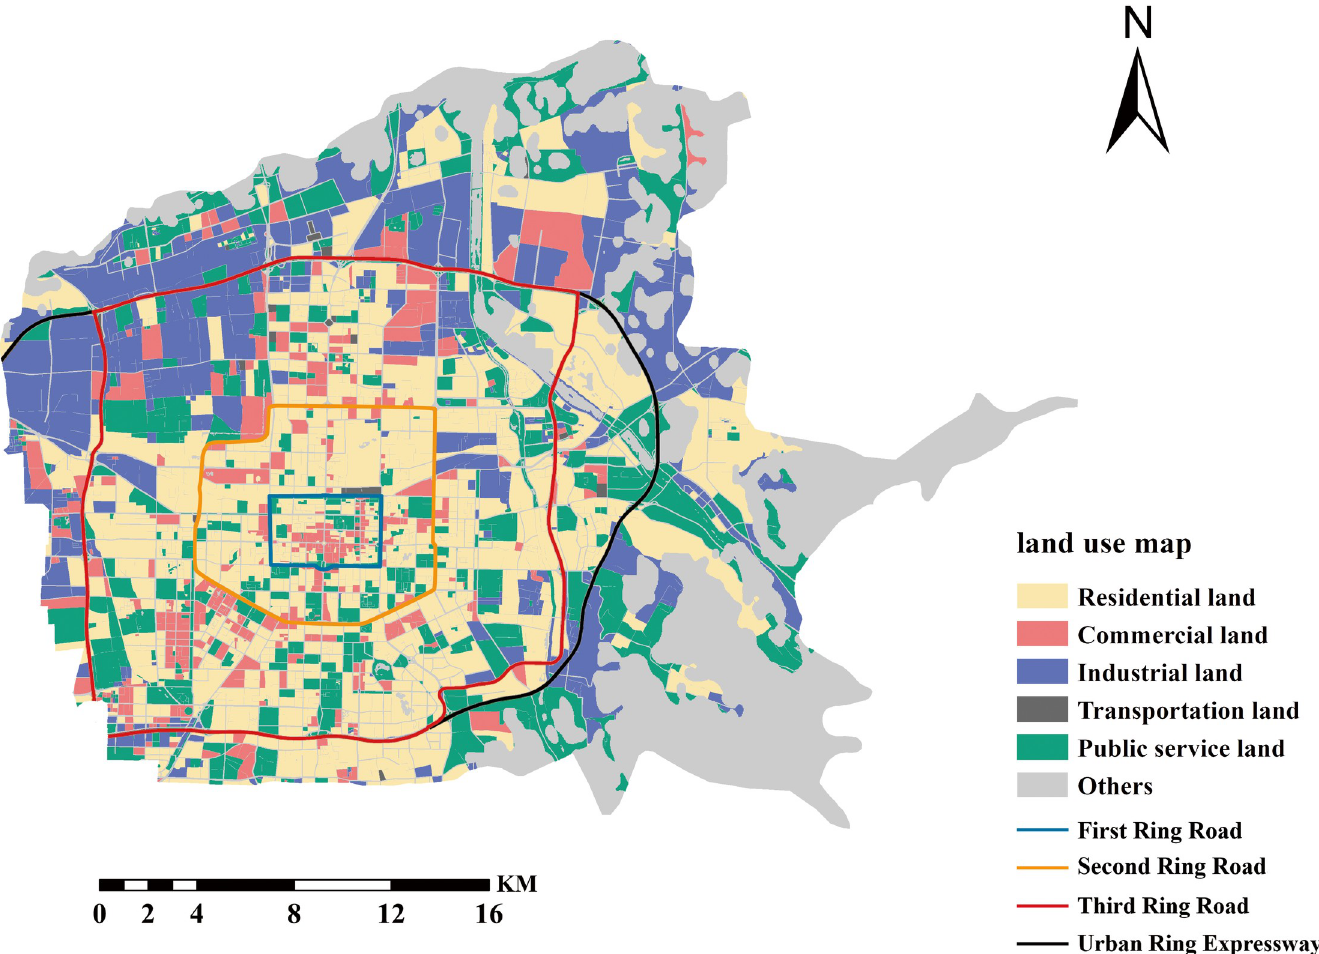
Fig 2. Land use map of the study area. The map images are from the National Catalogue service for Geographic Information: http://www.ngcc.cn/.